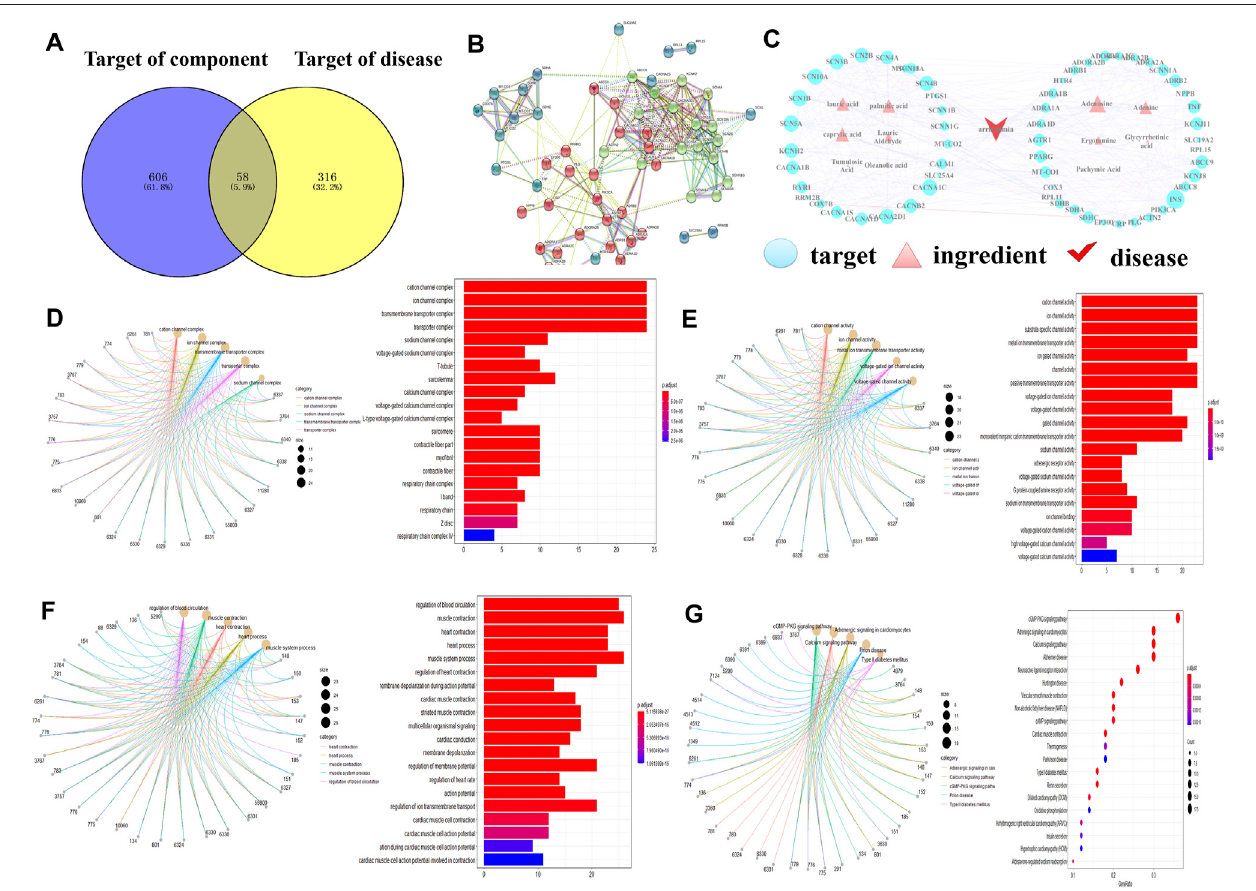
FIGURE 2| Network pharmacology prediction results. (A) ‘ Component-disease-target ’ intersection Venn diagram. (B) Intersection target PPI diagram. The closer thenodeswere,themorelikelytheyweretoappearred.Thelargerthenodes,theclosertherelationshipwasbetweenthecorrespondingtargetsandothertargetsinthe network. (C) ‘ Component-disease-target ’ network correlation diagram. (D) GO enrichment analysis - cellular component (CC). (E) GO enrichment analysis - molecular function (MF). (F) GO enrichment analysis - biological process (BP). (G) KEGG metabolic pathway analysis. Gene symbols were presented by PubMed Entrez ID.